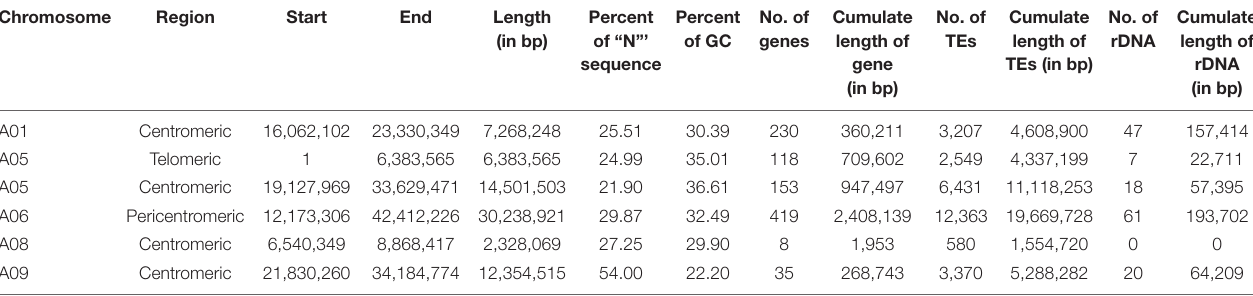
TABLE 1 | Position and length of the B. rapa ‘Z1’ genome-specific regions (in comparison to B. rapa ‘Chiifu’). Chromosome Region Start End Length